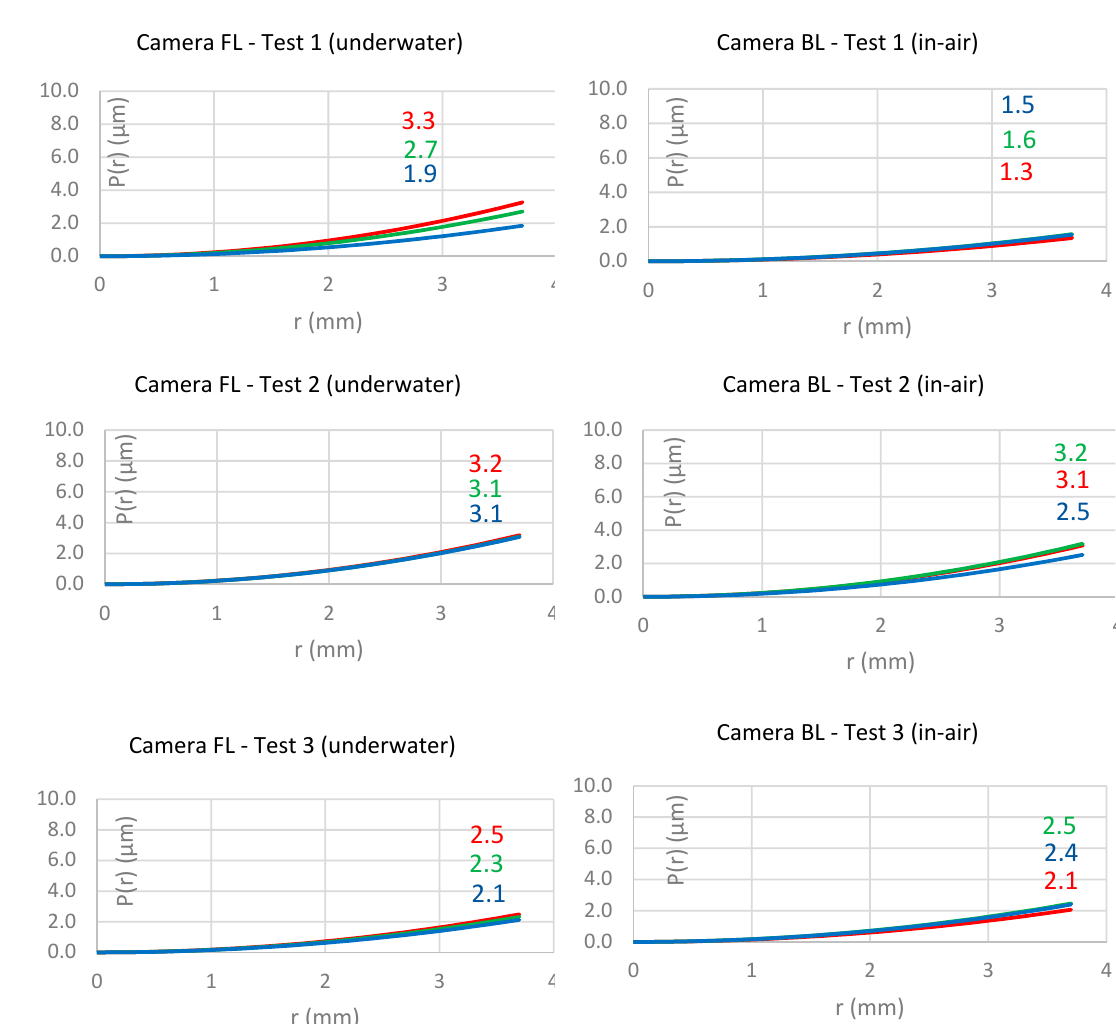
Figure 14. Comparison of the influence of the calculated decentering lens distortion parameters for the camera FL underwater ( left column) and the camera BL ( right column) with overall three repeats (rows) using the CMB adjustment. The colours indicate the results for the different bands (blue, green, red). The numbers indicate the distortion in µm at the maximum radial distance.